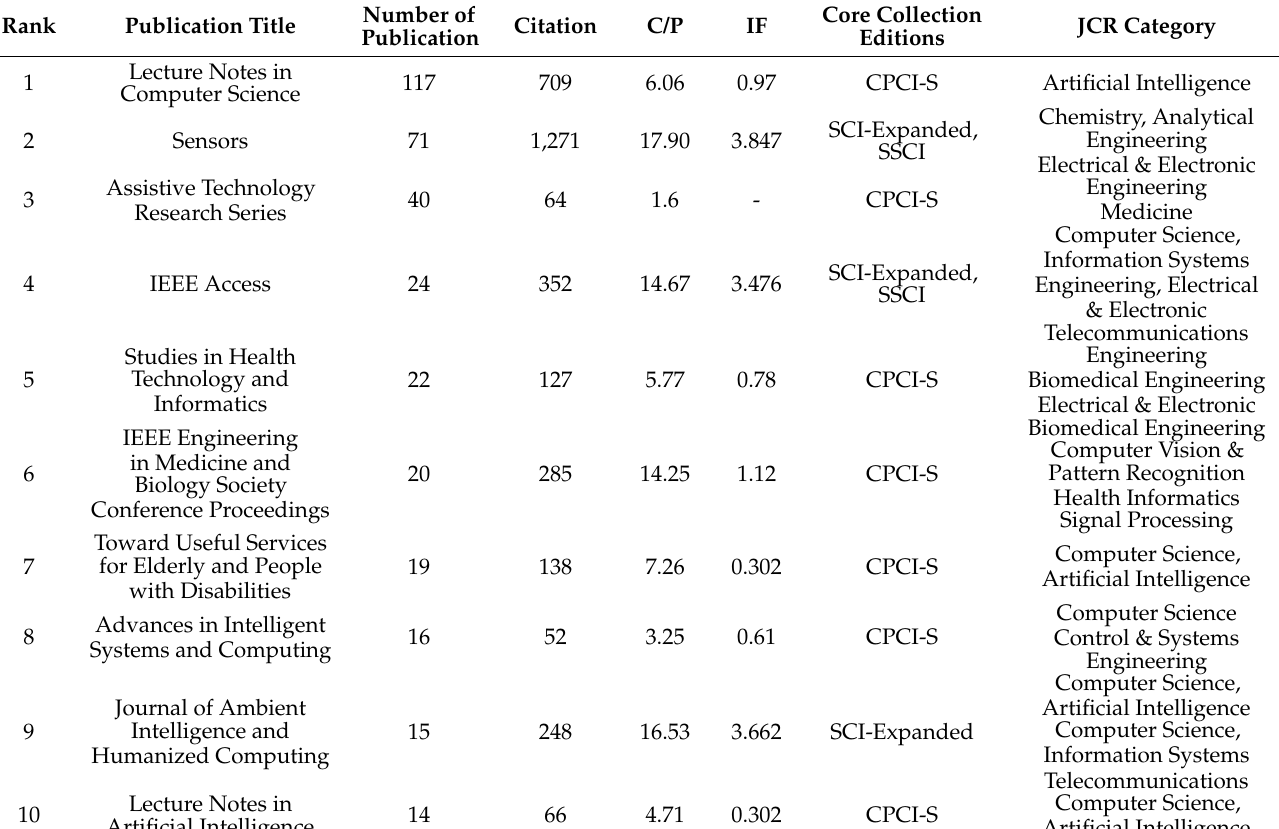
Table 2. Top 10 most productive publication